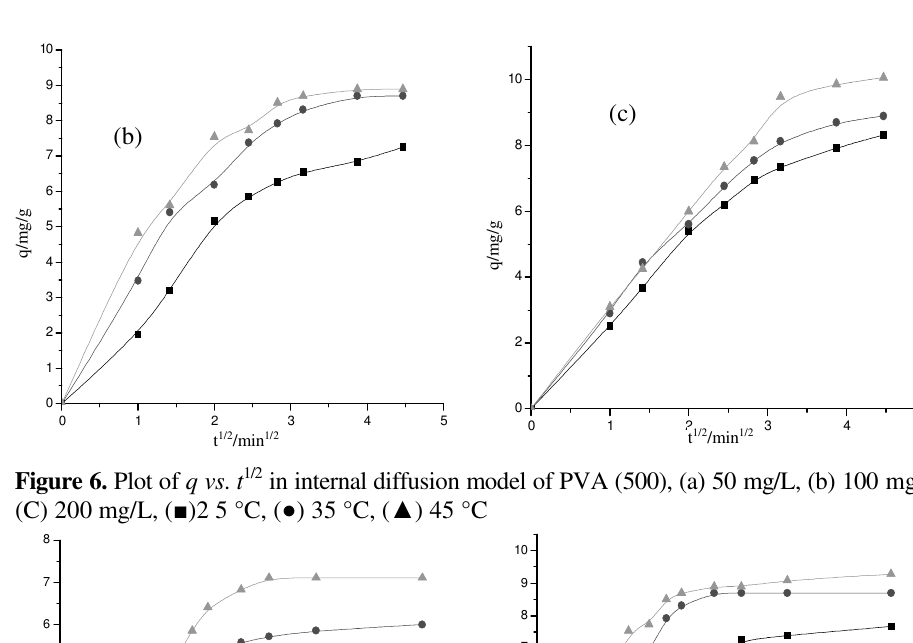
Figure 6. Plot of q vs . t 1/2 in internal diffusion model of PVA (500), (a) 50 mg/L, (b) 100 mg/L, (C) 200 mg/L, ( ■ )2 5 °C, ( ● ) 35 °C, ( ▲ ) 45 °C